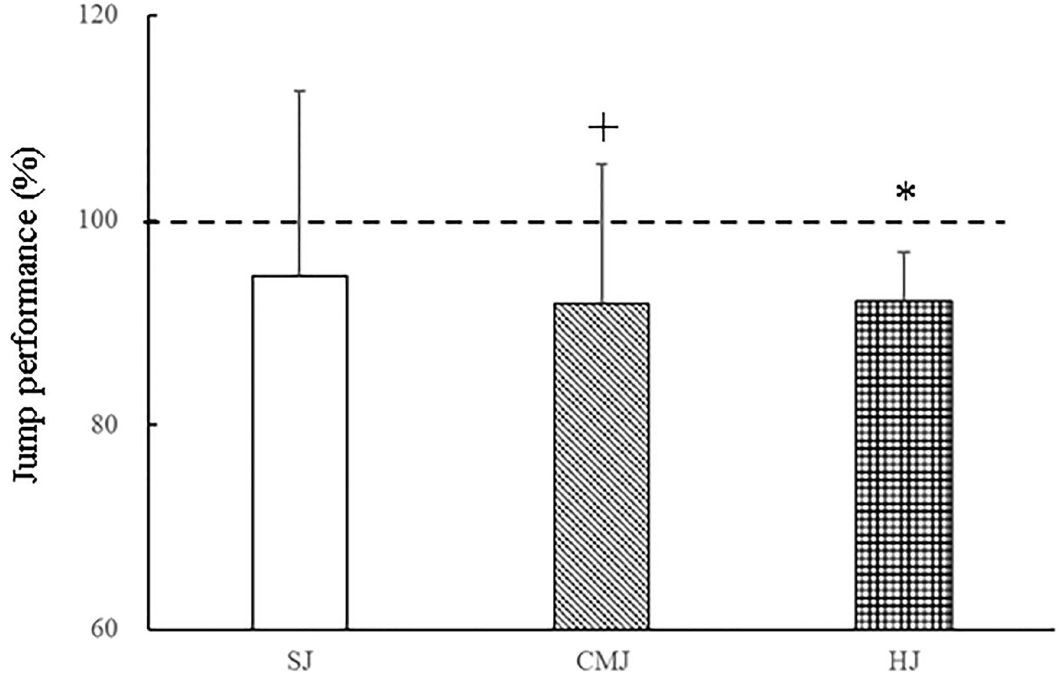
Fig 3. Relative differences in jump performance for the squat jump (SJ), countermovement jump (CMJ) and horizontal jump (HJ) under forefoot immobilisation (FFIM). Values are mean and SD. Jump heights in the SJ and CMJ were calculated from the net vertical impulse (Jump height _impulse). The dashed line at 100% indicates the level without a splint (BARE). + and � denote significant differences between BARE and FFIM at p < 0.05 and p < 0.01, respectively.